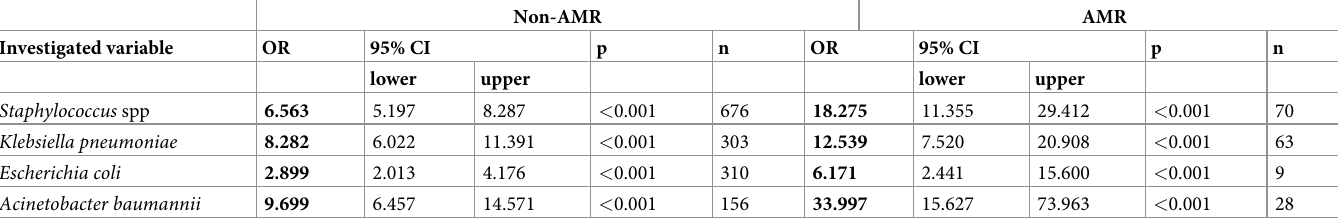
Table 6. Univariate analysis for intrahospital decease associated with AMR infections and non-AMR infections. Investigated variable